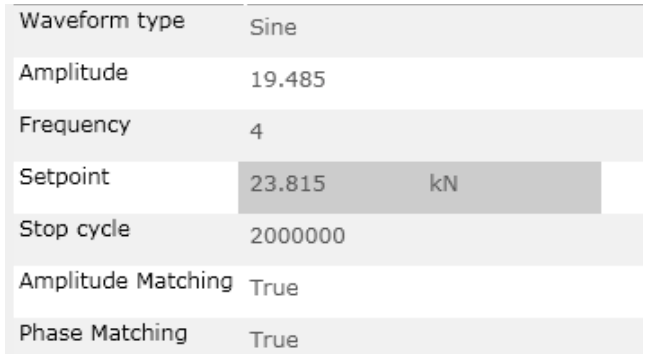
Figure 21. Fatigue loading and cycle setting.